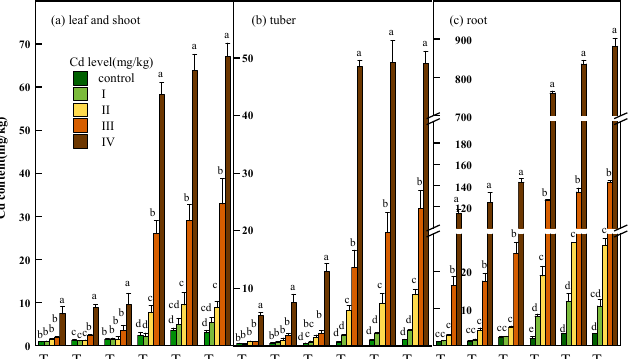
Figure 3. Cd content in leaf and shoot ( a ), tuber ( b ) and root ( c ) of B. striata plants under Cd treatment control, I, II, III and IV. T i–j means B. striata harvested at a certain point (i = 1,2, represents the year after transplanting; j = 7,8,9, represents the month for sampling). Error bars indicate standard deviation calculated for three replicates. Significant effects of treatment on values for Cd content are denoted by different lowercase letters (one-way ANOVA, p < 0.05).